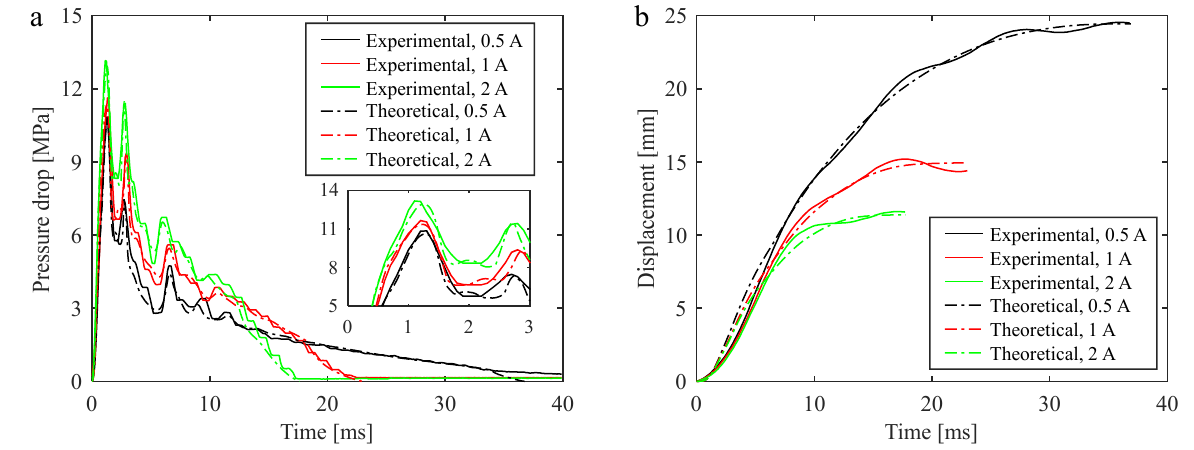
Figure 12. Comparison of the theoretical pressure drop and displacement values with experimental results for different excitation currents.